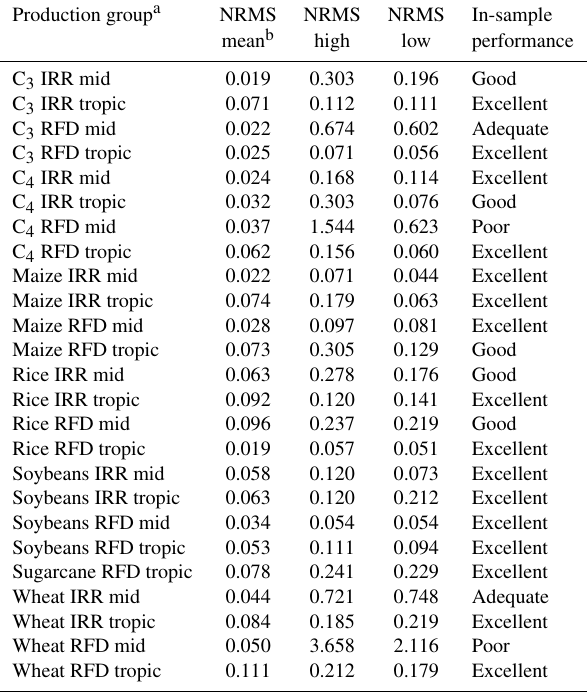
Table A5. Persephone v1.0 response function performance for all production groups, for cross µ CTW (Eq. A3), quadratic σ CTW (Eq. A6).